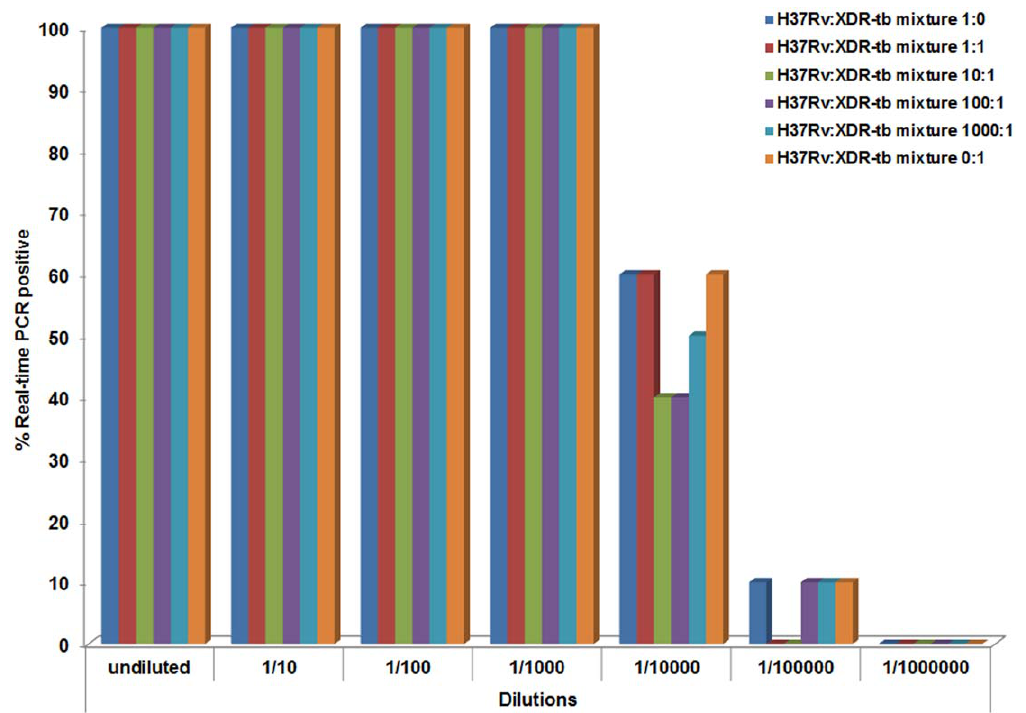
Figure 4. Determination of dilution for digital PCR. The DNA of each H37Rv:XDR-TB mixture was diluted 10 fold serially and subjected to real- time PCR using the rpoB primers and probes. The percent of PCR reactions that amplified at each dilution is shown. The target one-half genome equivalent DNA is the amount of DNA that yielded 50% positive [10].